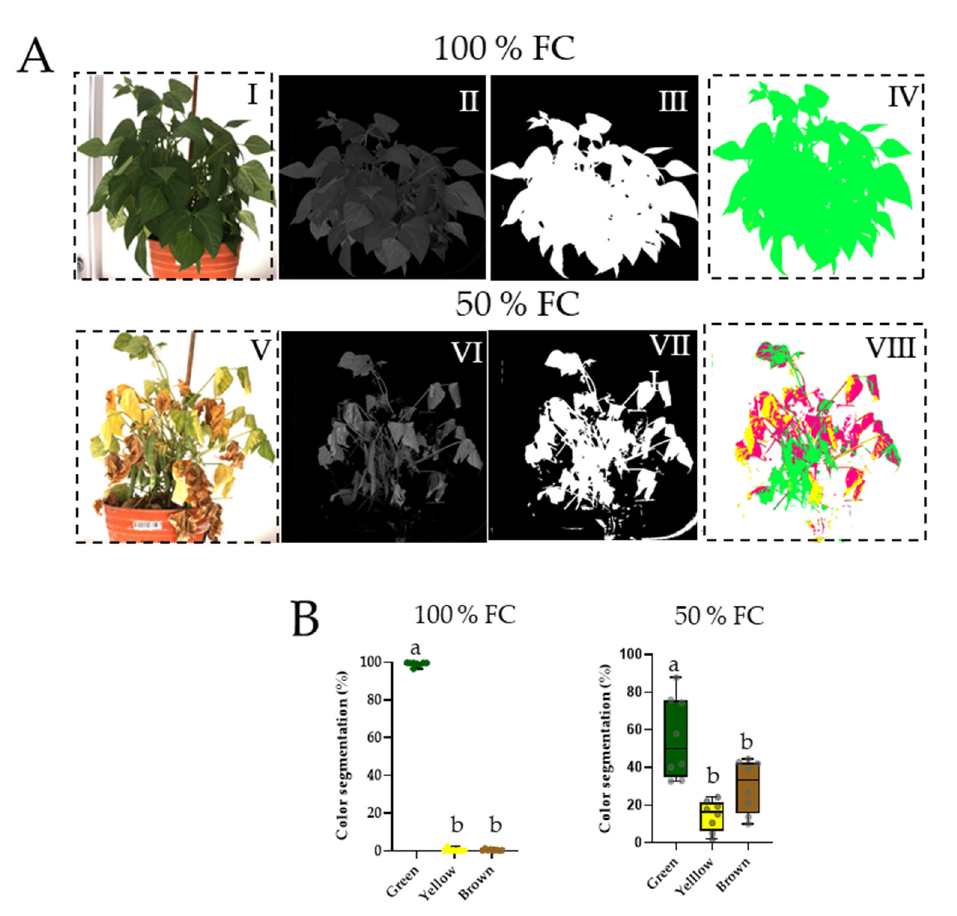
Figure 1. ( A ) Color segmentation of RGB images of common bean plants of cv. OTI in soil with 100% field capacity (FC) and after 10 d at 50% FC. The images were obtained with a Scanalyzer PL and analyzed by LemnaGrid Software. Foreground and background separation of the images and resulting binary images ( I – III , V – VII ). Objects were separated according to color classification ( IV – VIII ). ( B ) Percentage ( ± S.E.) of color in green (healthy), yellow (senescent), and brown (necrotic) plants, n = 5. Boxes marked with a different letter were significantly different ( p < 0.05) by Student’s t test.